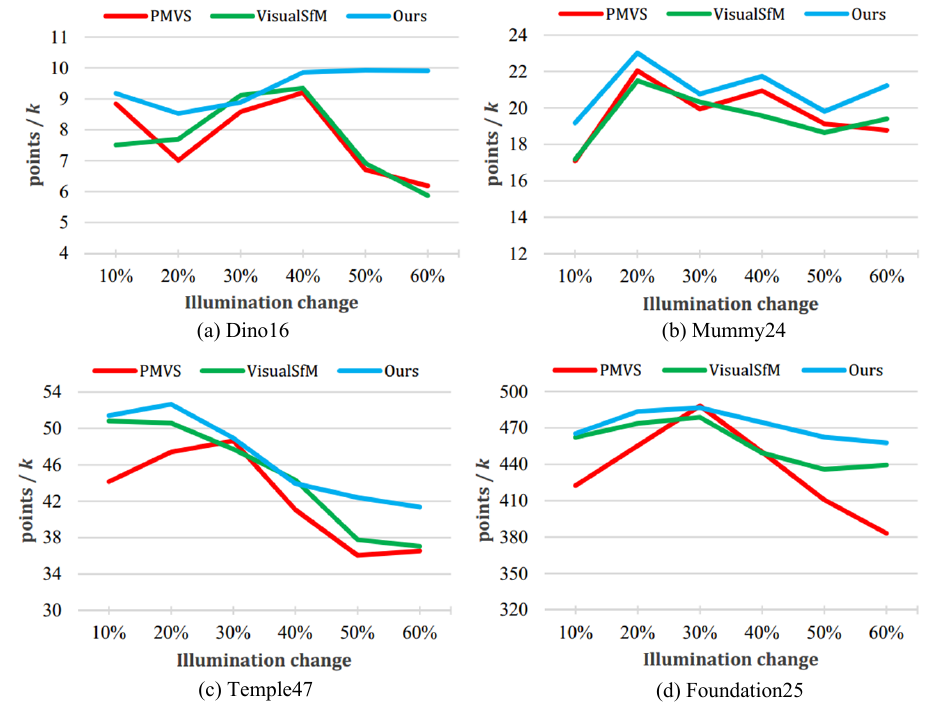
Figure 8. Comparison of the recovered points by three reconstruction methods under different illumi- nation variations (10% to 60%). Four datasets are tested and they are ( a – d ): “Dino16”, “Mummy24”, “Temple47”, and